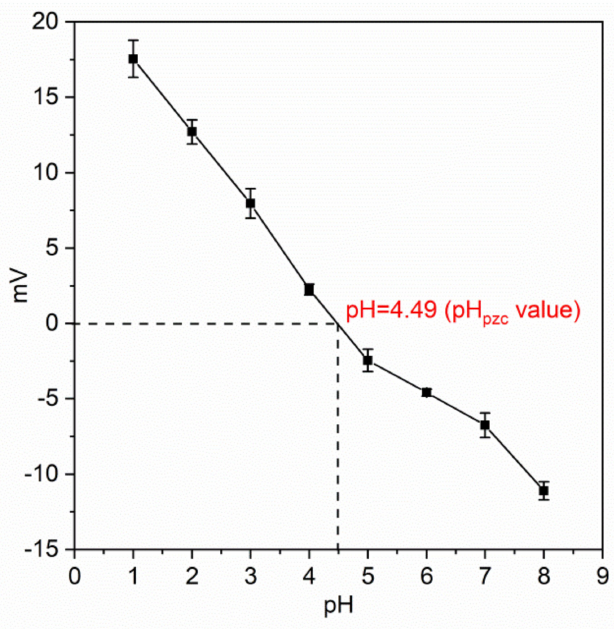
Figure 7. Zeta potential of